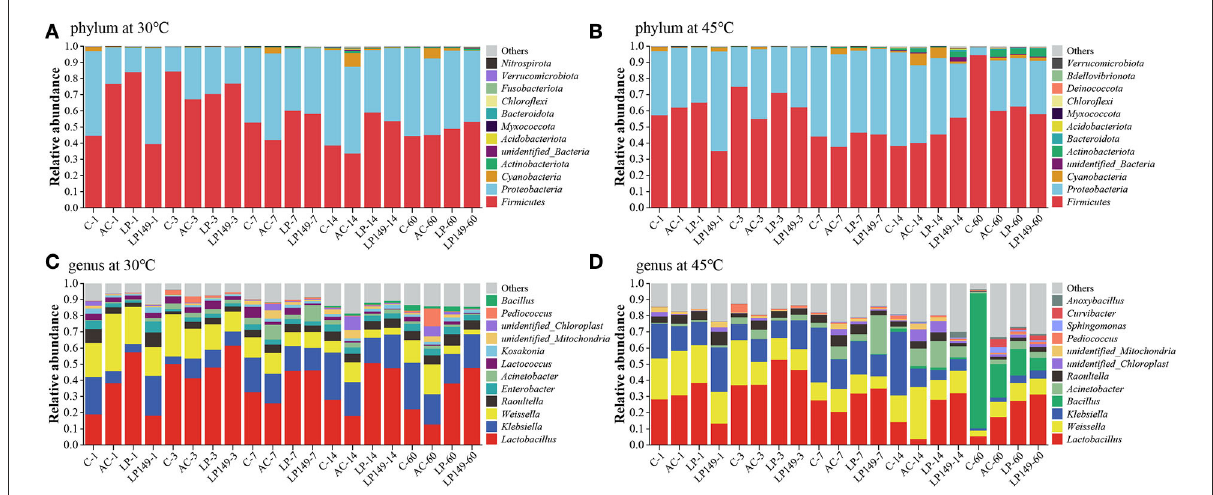
FIGURE4 Relative abundance of bacterial community at phylum (A,B) and genus (C,D) level. C, control; AC, Acremonium cellulase; LP, commercial inoculant Lactobacillus plantarum ; LP149, Lactobacillus plantarum 149. The number after the treatment zone represents the ensiling time: 1, 3, 7, 14, and 60 represent 1, 3, 7, 14, and 60 days of ensiling,